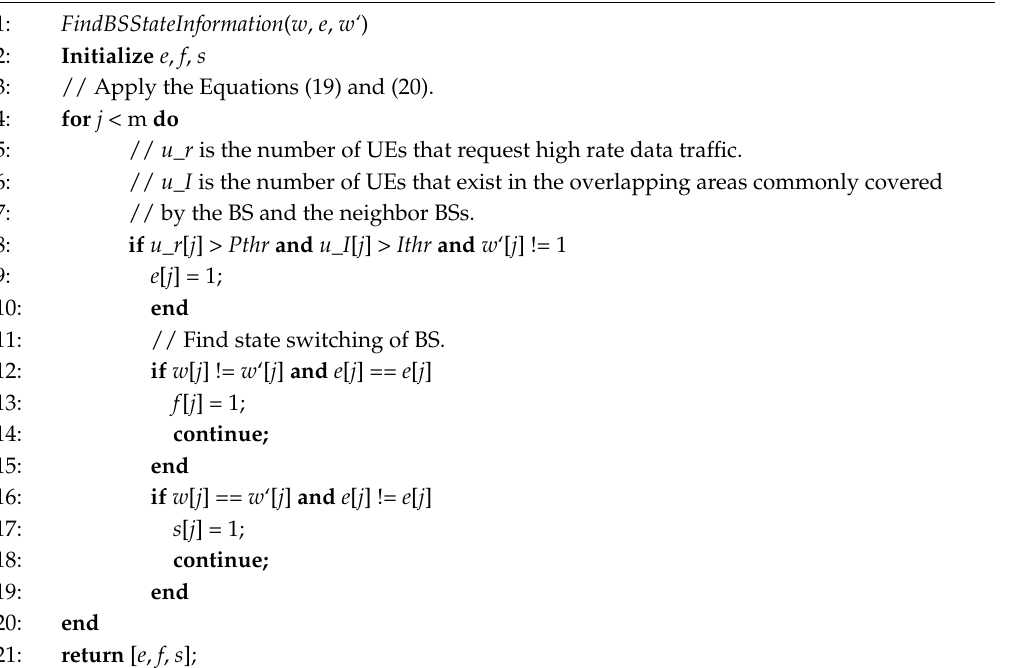
Algorithm 3. Find State Information of